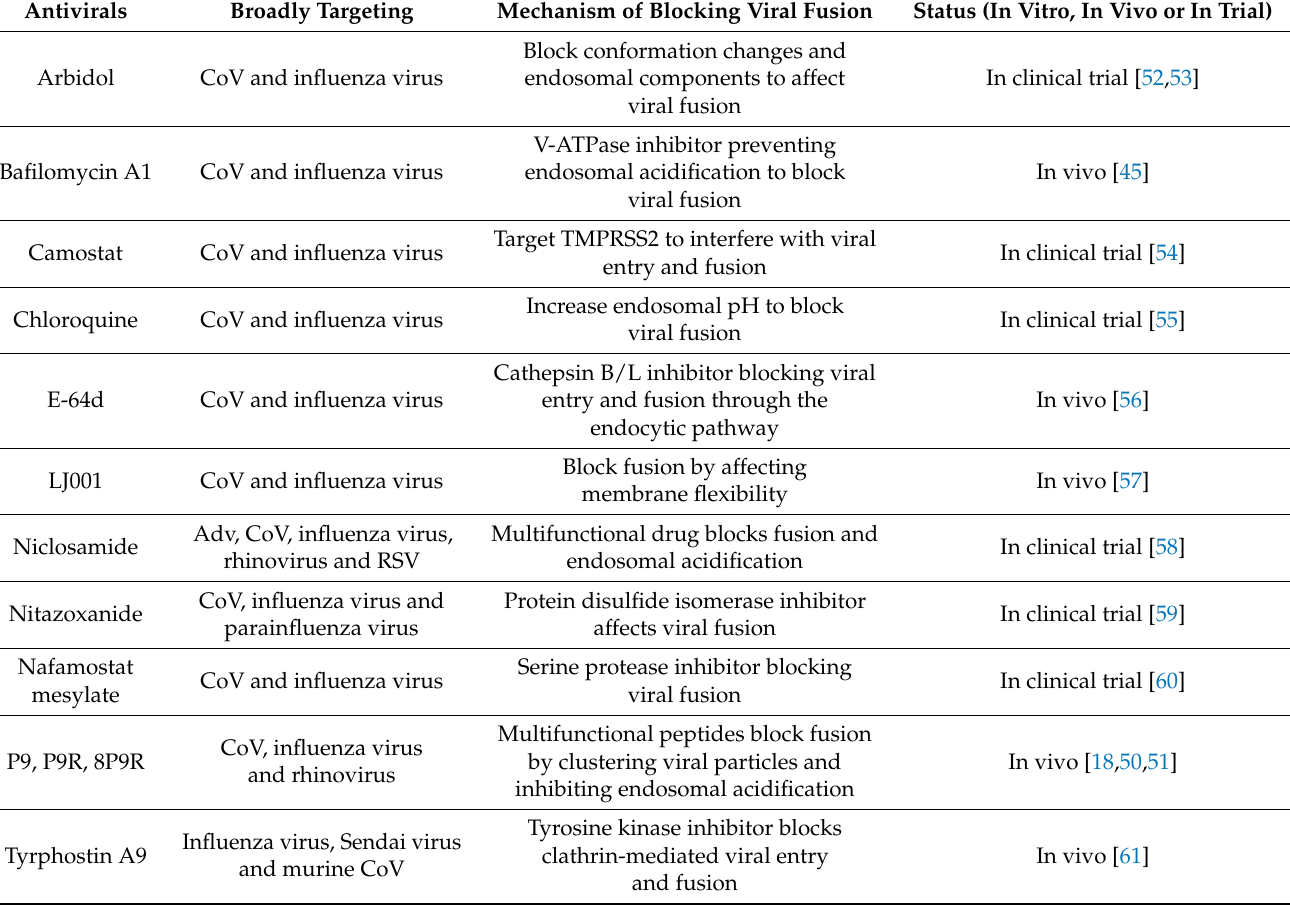
Table 1. Viral fusion inhibitors with broad-spectrum activities against viruses in